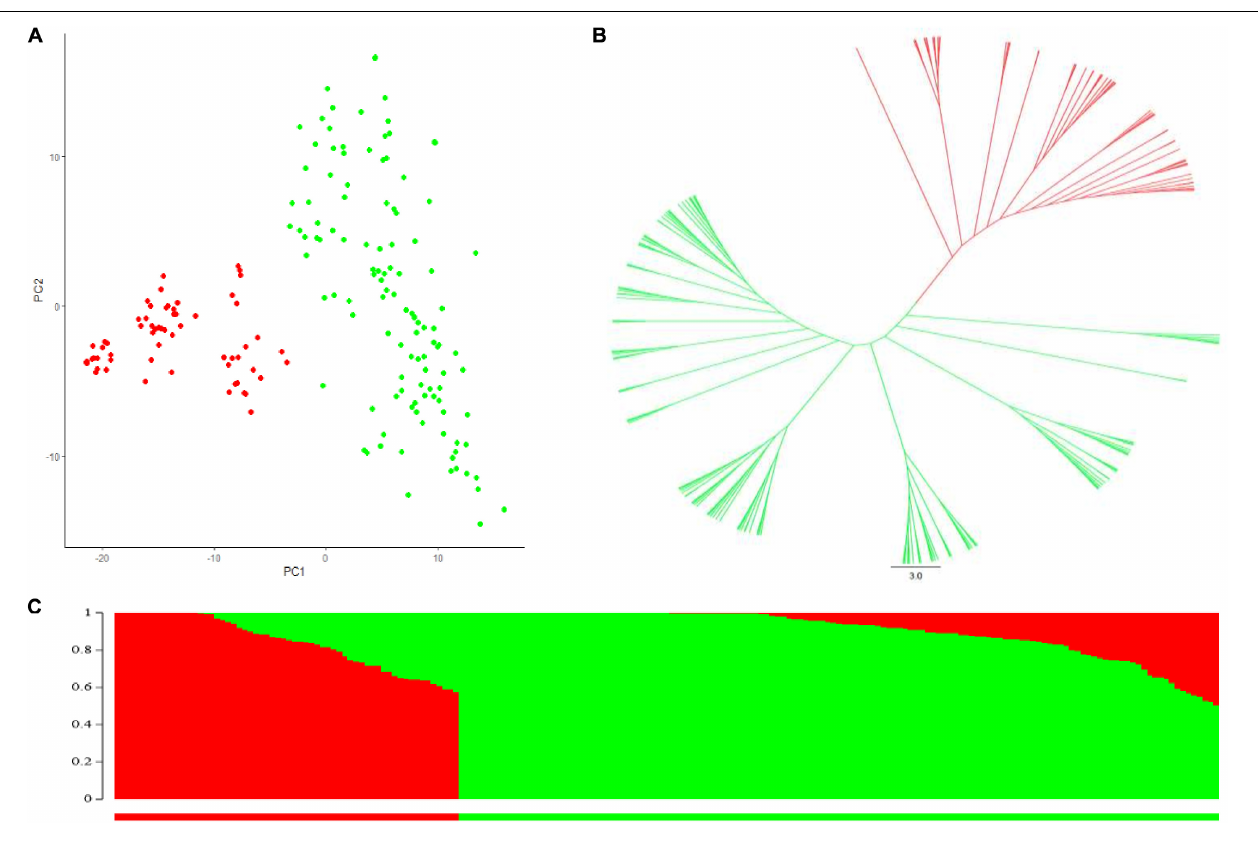
FIGURE 1 | Population structure analysis of the durum association mapping (AM panel). (A) Principal component analysis (PCA). (B) Phylogenetic tree constructed with Neighbor Joining (NJ) method, green color and red color represented subpopulations 1 and 2 inferred from Structure analysis. (C) Population structure analysis with K = 2 of the AM panel. Green color, subpopulation 1 and red color subpopulation 2.